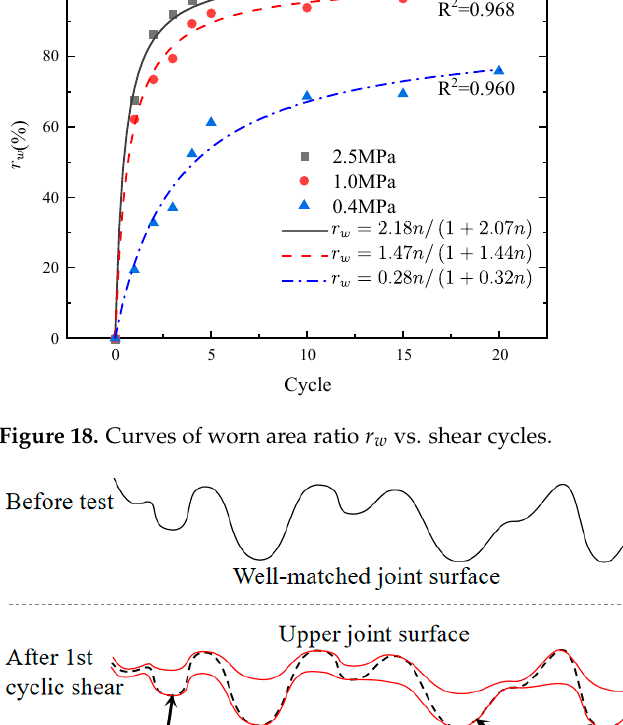
Figure 19. Local damage evolution under low normal stress.